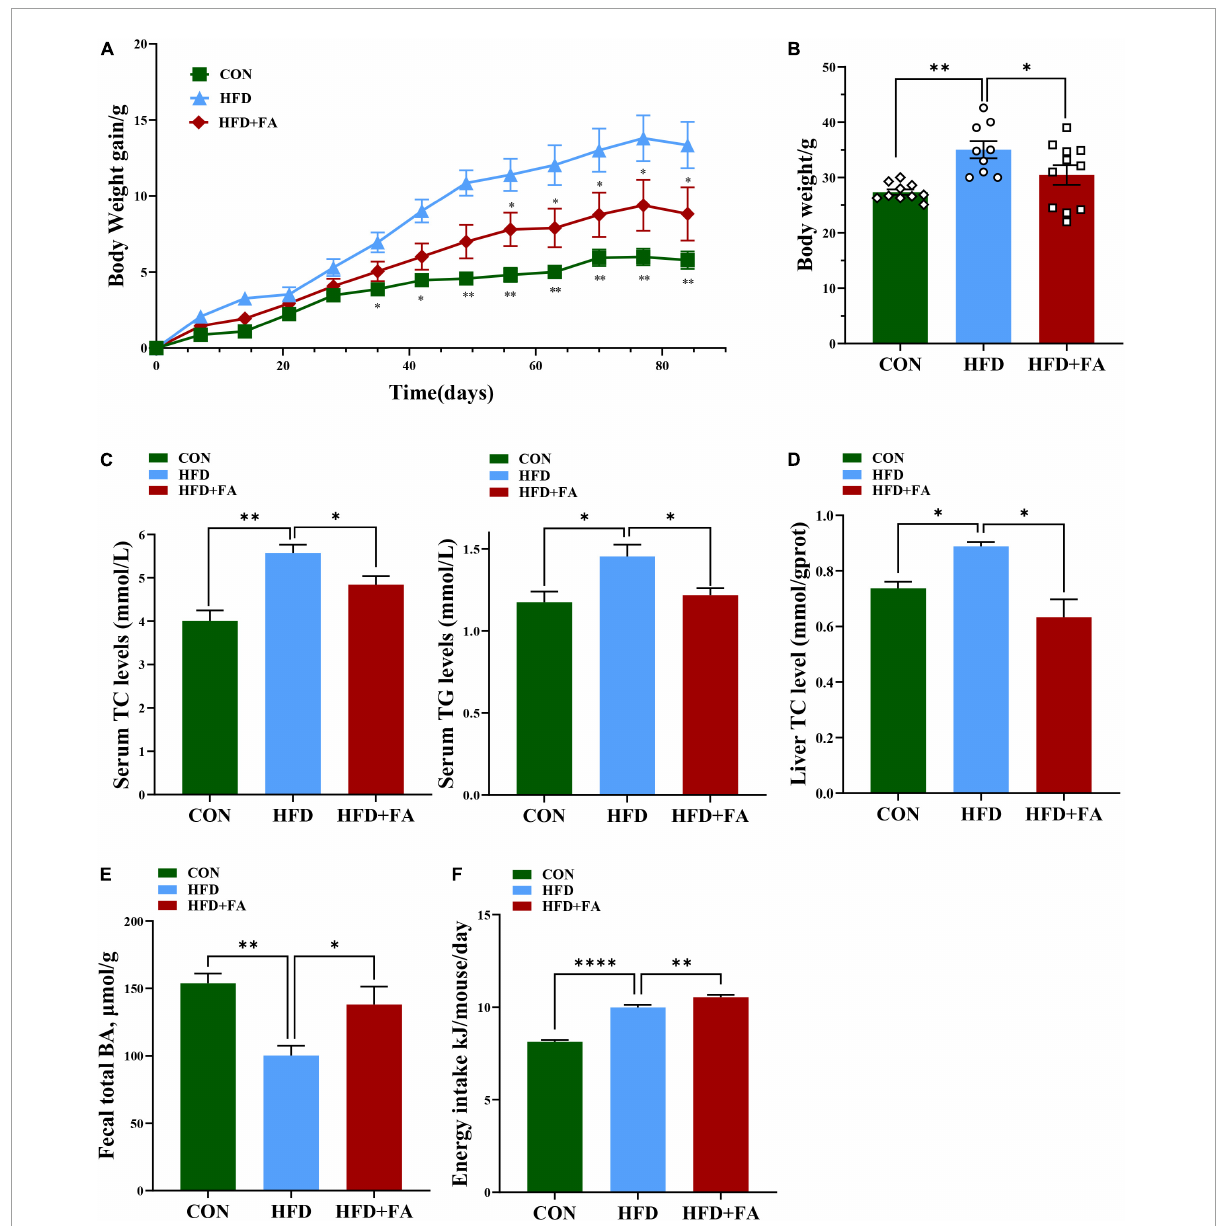
FIGURE1 FA alleviates hypercholesterolemia and increases excretion of total bile acids in feces. (A) Body weight gain change curve (12 weeks). (B) Body weight (g). (C) Serum TC and TG levels (mmol/L). (D) Hepatic TC levels. (E) Fecal total BAs level. (F) Energy intake (Kj/mouse/day). Data are shown as mean ± SEM ( n = 9–10). Statistical analysis was performed using one-way ANOVA followed by Dunnett’s multiple comparison test. ∗ p < 0.05; ∗∗ p < 0.01; ∗∗∗∗ , p < 0.0001. CON, control diet group; HFD, high-fat diet group, HFD + FA, high-fat diet with 100 mg kg/bw/day FA